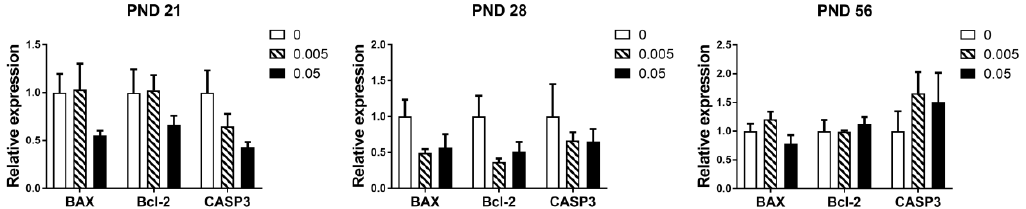
Figure 4. Effects of maternal exposure of T-2 toxin on the expression of apoptosis-related genes in the testes of offspring. Each value represents the mean ± SEM of the group ( n = 4).